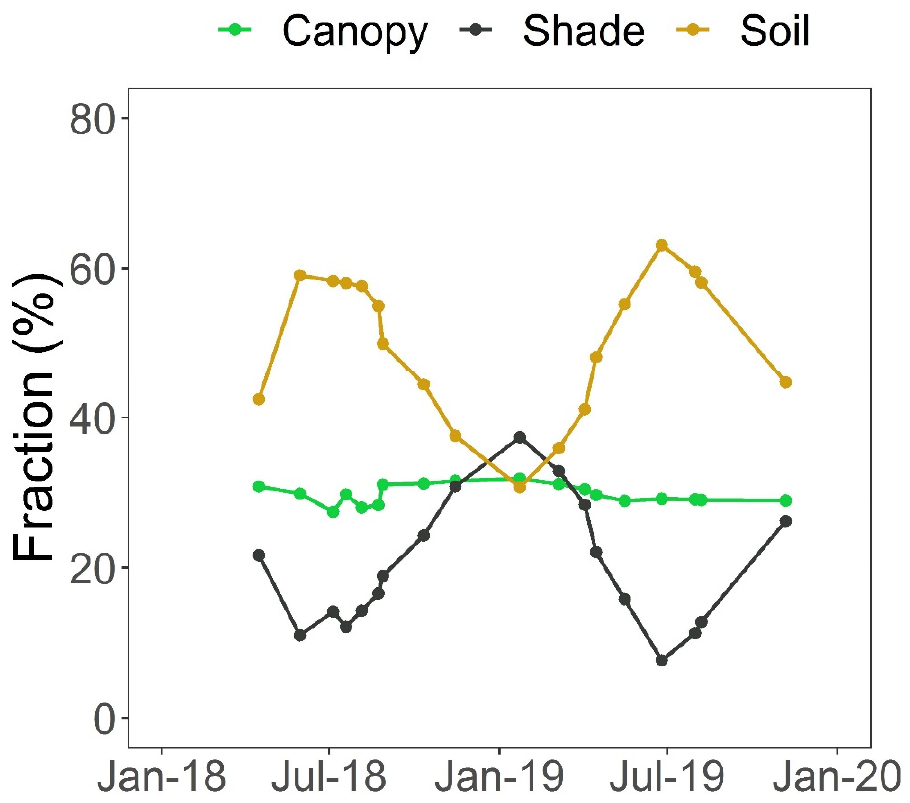
Figure 4. Variations in the fraction of canopy, exposed, and shaded soil in the tower area are presented in green, black, and brown, respectively. Symbols with different colors on the same date are fractions that were calculated from the same UAV flight with sums equal to 100%.